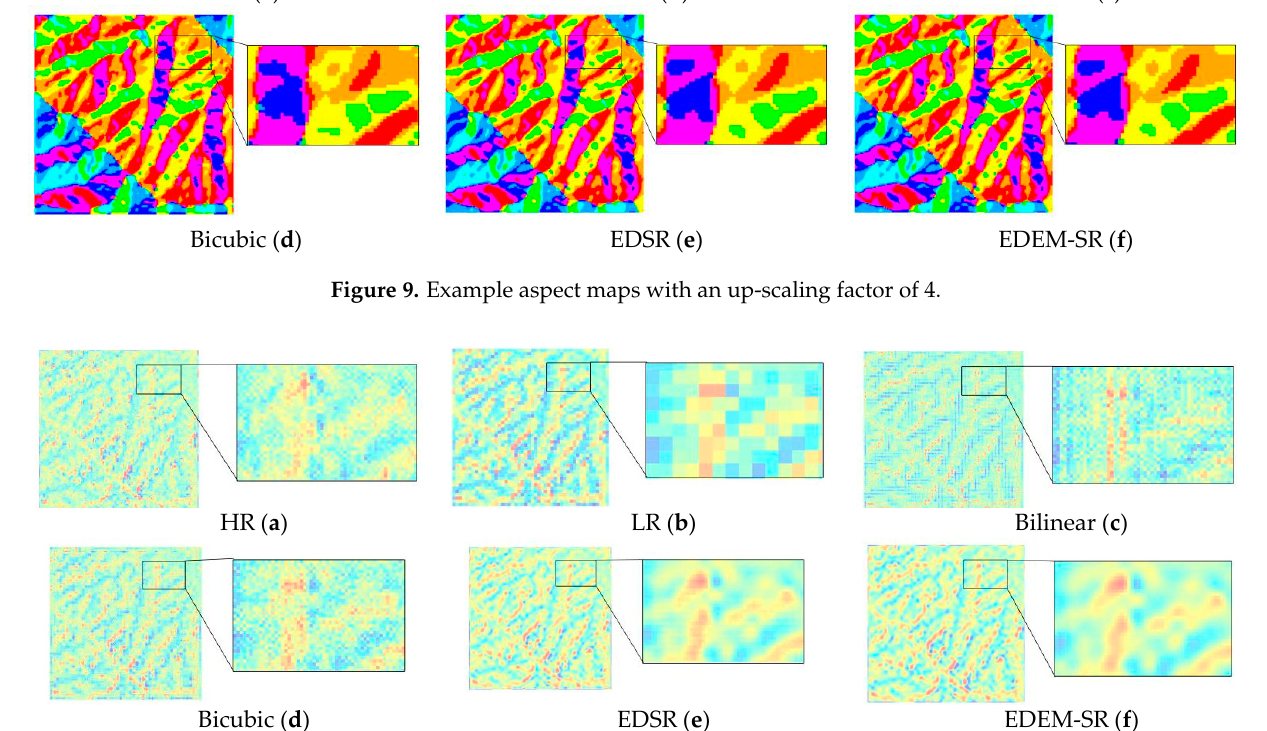
Figure 10. Example curvature maps with an up-scaling factor of 4.